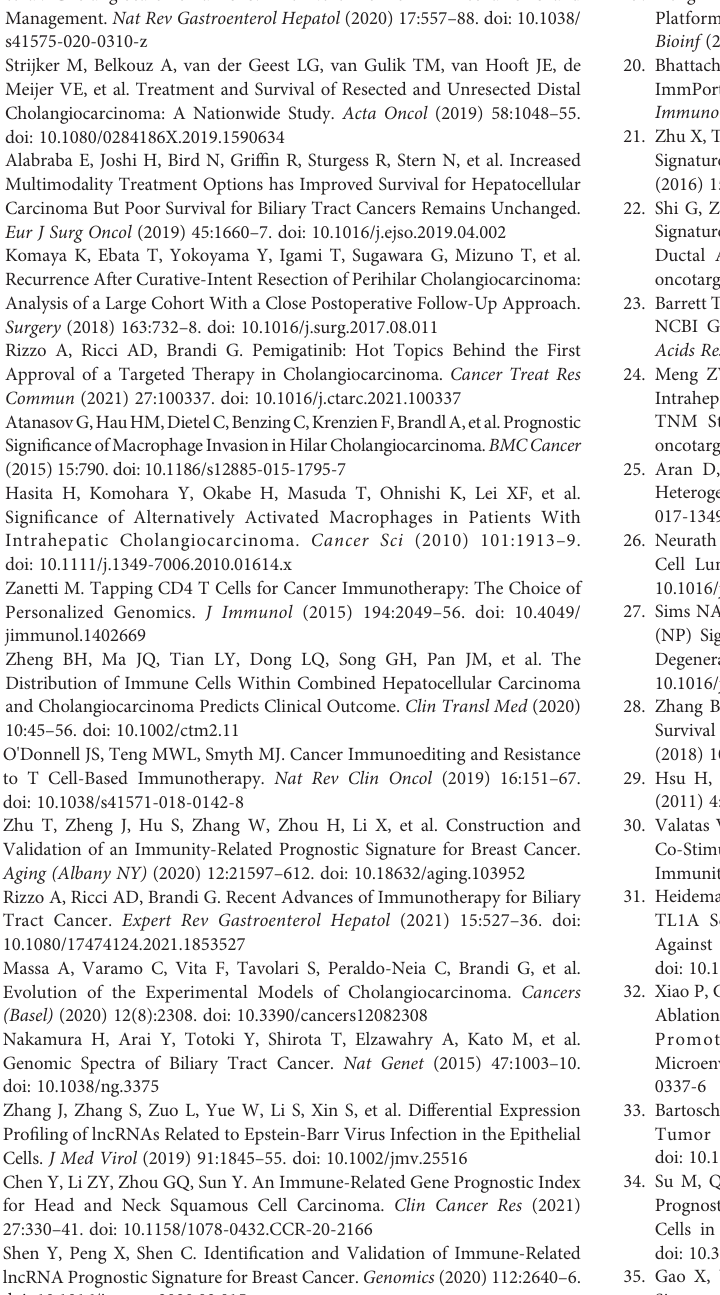
Supplementary Figure 10 | Univariate survival analysis for the clinical factor and risk score in Renji Hospital.